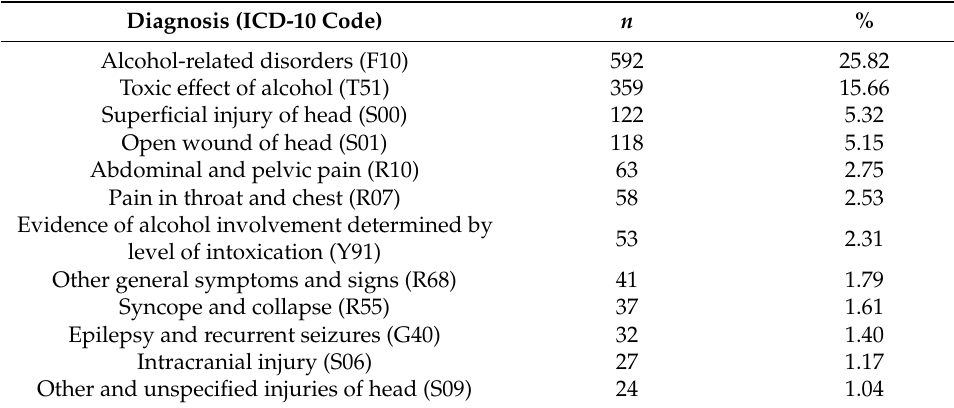
Table 4. Most common diagnoses in patients under the influence of alcohol in the emergency department in ICD-10 coding system.